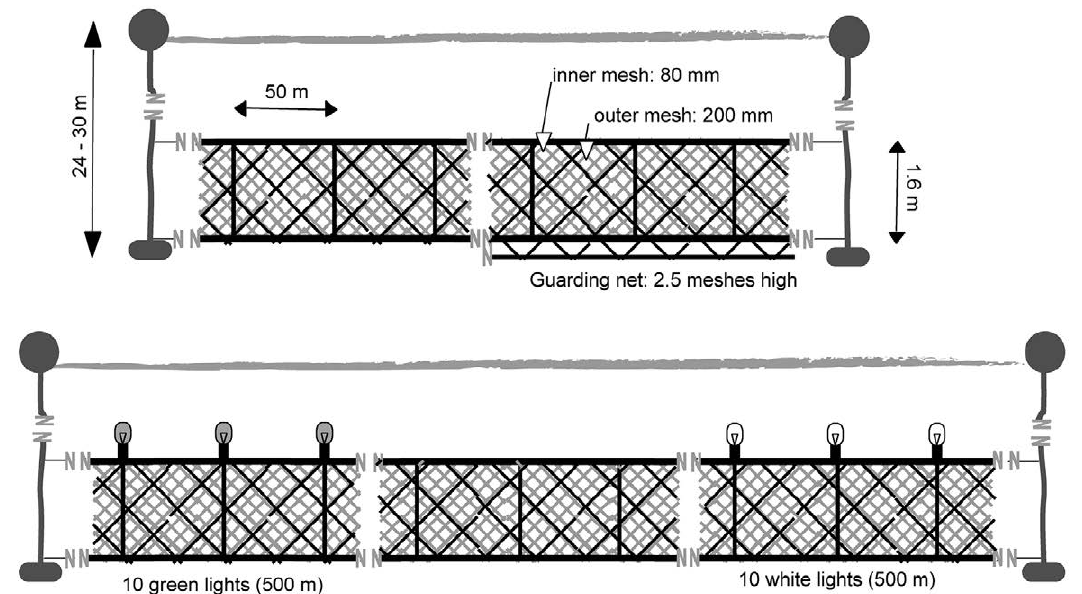
Fig. 1. – Schematic design of the trammel nets used in the experiments. Each trammel net was built of 30×50-m panels (total length 1500 m) with a vertical span of approximately 1.6 m, using 80-mm inner meshes and 200-mm outer meshes. The control trammel net is shown in the top left figure. The modified trammel net with a guarding net was created by adding 2.5 meshes (of the external type, i.e. 200 mm) between the footrope and the panel (top right). In the second experimental trammel net, the net was divided into 3×500-m sections (10 panels each). Two of the sections were fitted with green or white lights every 50 m and one section was left unmodified. The position of the three sections along the net was randomized from one day to another during the